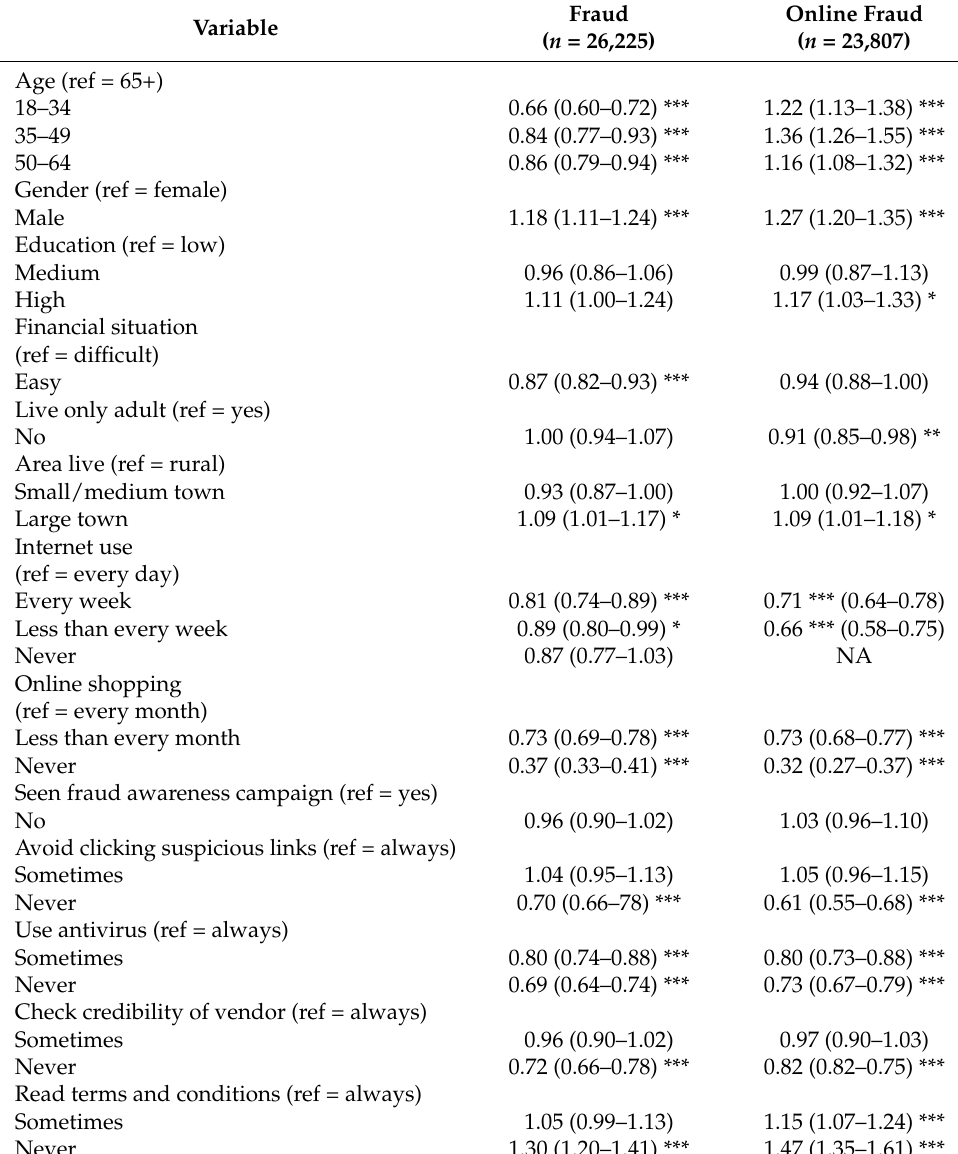
Table 8. Odds ratios and 95% CI for fraud and online fraud